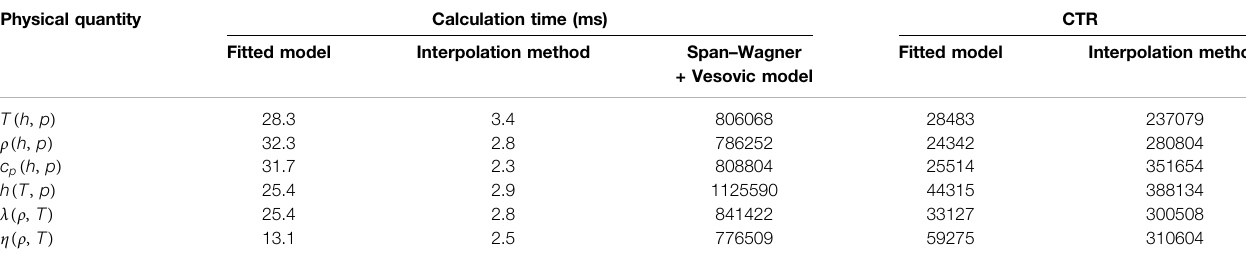
TABLE 15 | Comparison of calculation time (for 10 5 working conditions).